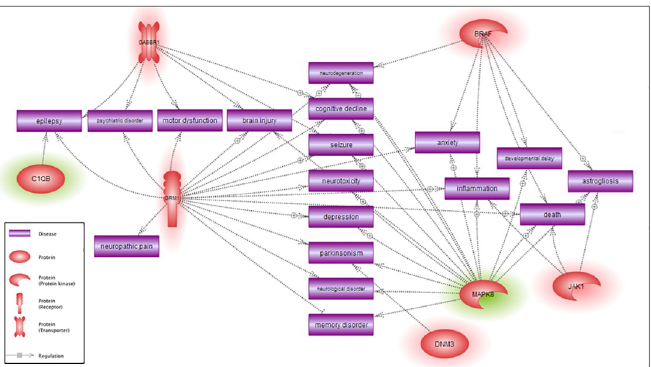
Fig 6. Gene-disease relationship network of significant DEGs in GalCer- versus vehicle-treated male Cln3 Δ ex7/8 mice. Pathway Studio software generated network interactions between diseases and most significant DEGs in male Cln3 Δ ex7/8 mouse brain (p-value < 0.05, stringency � ± 1.3 fold-change in expression). Depiction of genes is by their gene symbols. Upregulated genes are highlighted with a red halo and downregulated genes are highlighted with a green halo. Indirect regulation is indicated by dotted gray lines.